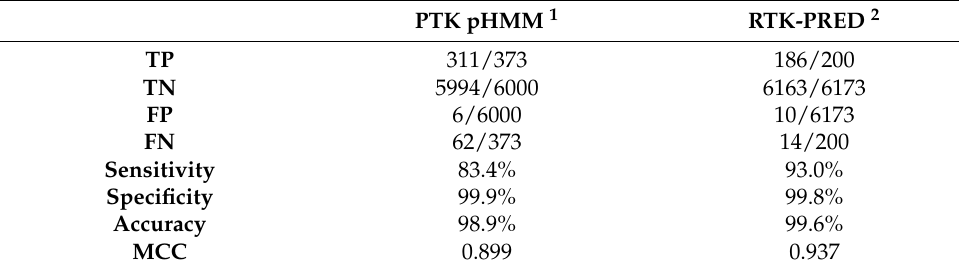
Table 2. Validation of the custom PTK pHMM and